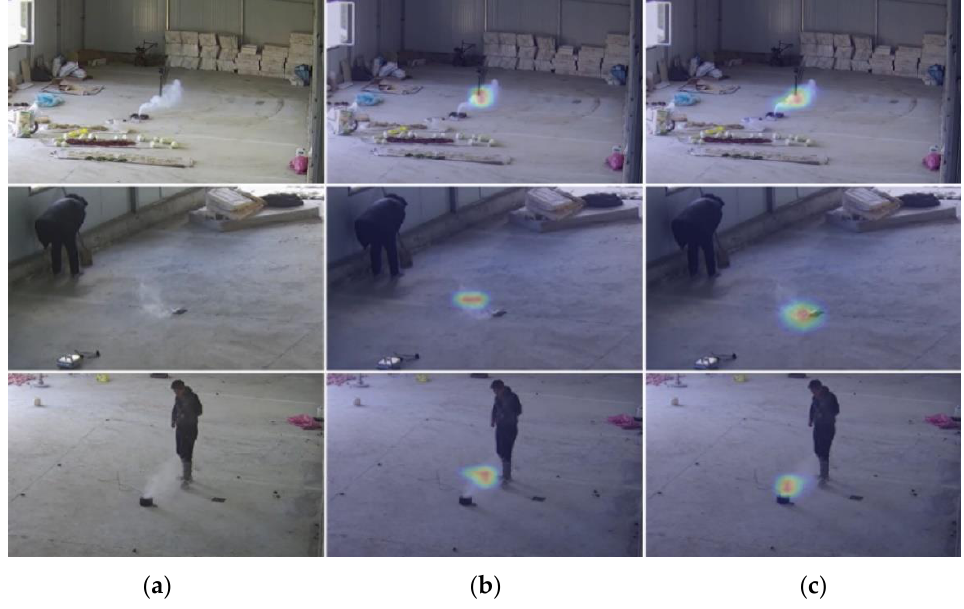
Figure 9. Heatmaps of the attention mechanism. ( a ) are different original images of small and thin smoke; ( b ) are the detections of ( a ) with no attention; ( c ) are the detections of ( a ) with our attention mechanism. After adding attention, the focus on small smoke will be closer to the source of the smoke.